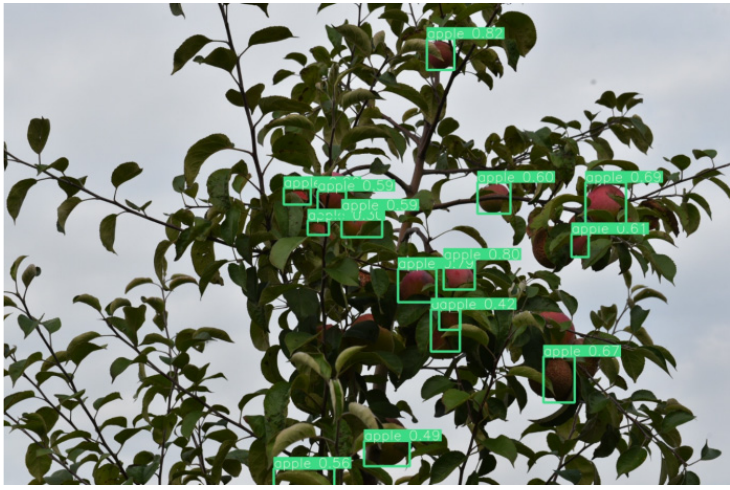
Figure 8. Apple detection in pictures. Table 3. Comparative analysis of red and green apple detection. Table 2. Comparative analysis of apple detection algorithms.